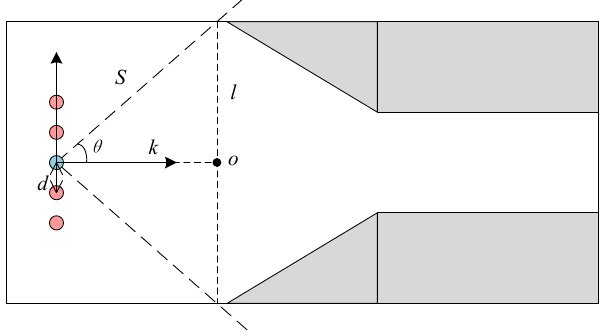
Figure 5. Road narrowing in front of the UGVs fleet.